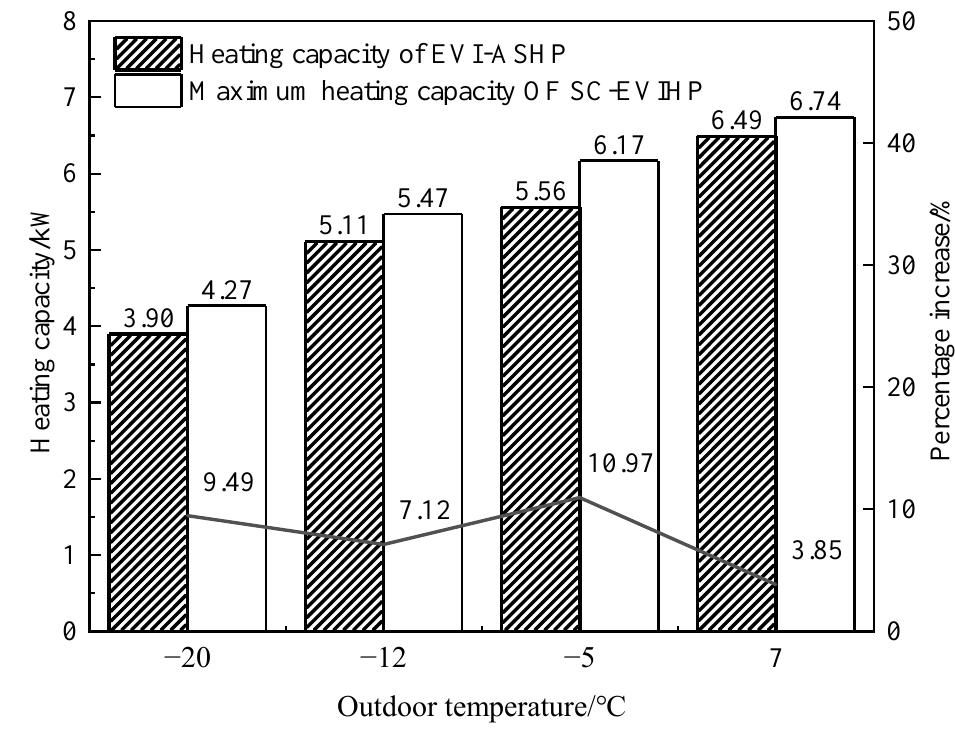
Figure 13. Heating capacity comparison at different outdoor temperatures.